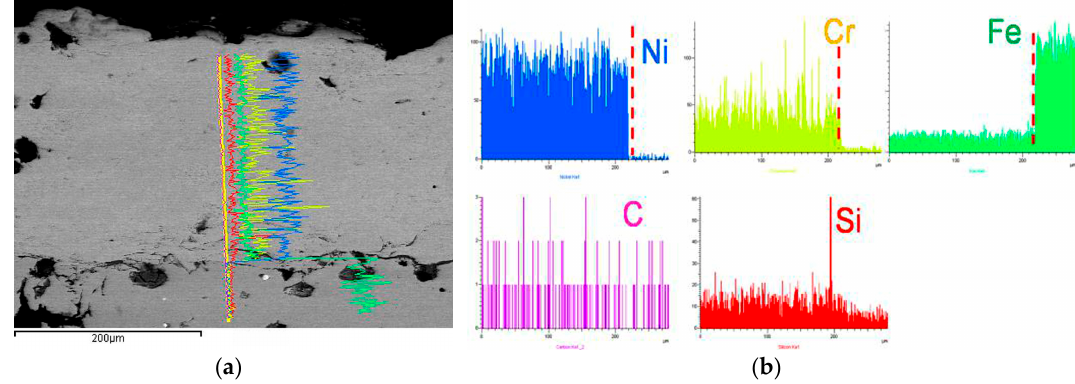
Figure 6. EDS element analysis of the as-sprayed Ni60 coating: ( a ) line analysis of elements; ( b ) element distribution along the line.